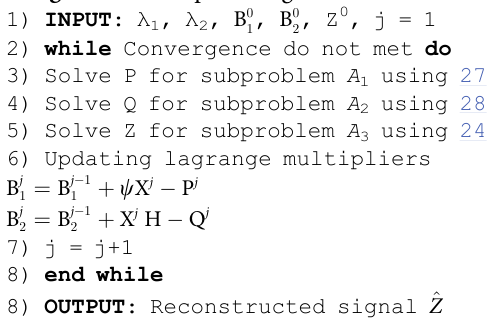
Algorithm 1 Proposed